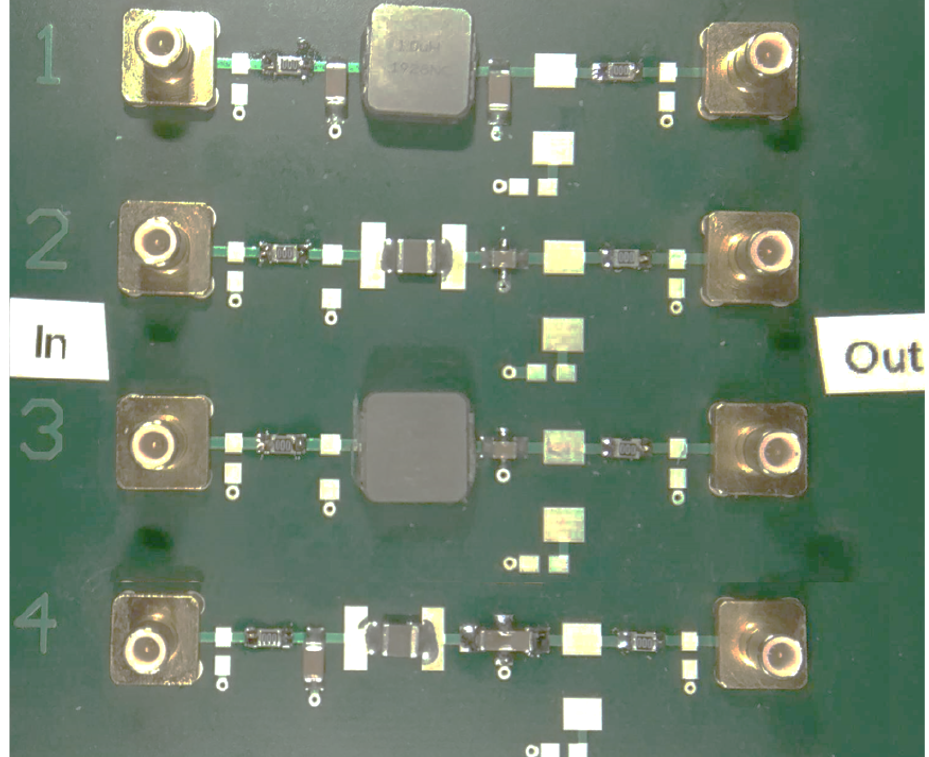
Figure 5. Power Filter Test Board (see four listed distinct